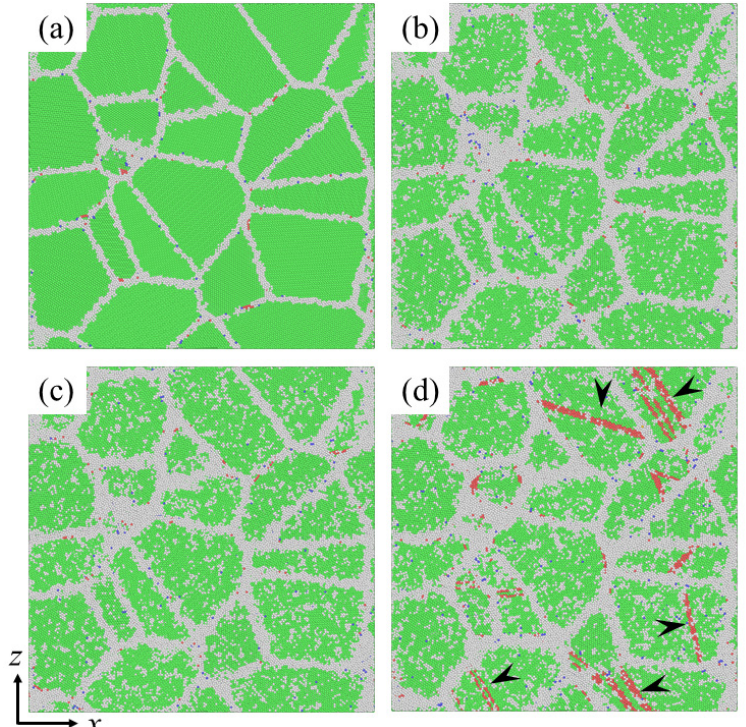
Figure 6. Snapshots of segregated Ni-Mo (3 at.%) samples with d = 10.9 nm at 1100 K ( a ) before creep; ( b – d ) after creep for 200 ps under an applied stress of 0.6 GPa, 1.0 GPa and 1.6 GPa, respec- tively.